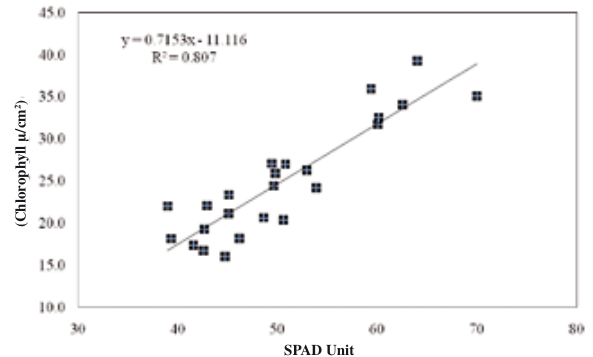
Table 6 - Pineapple leaf characteristics of the ratoon crop as affected by irrigation treatments when harvested at the fruit developing stage Treatments